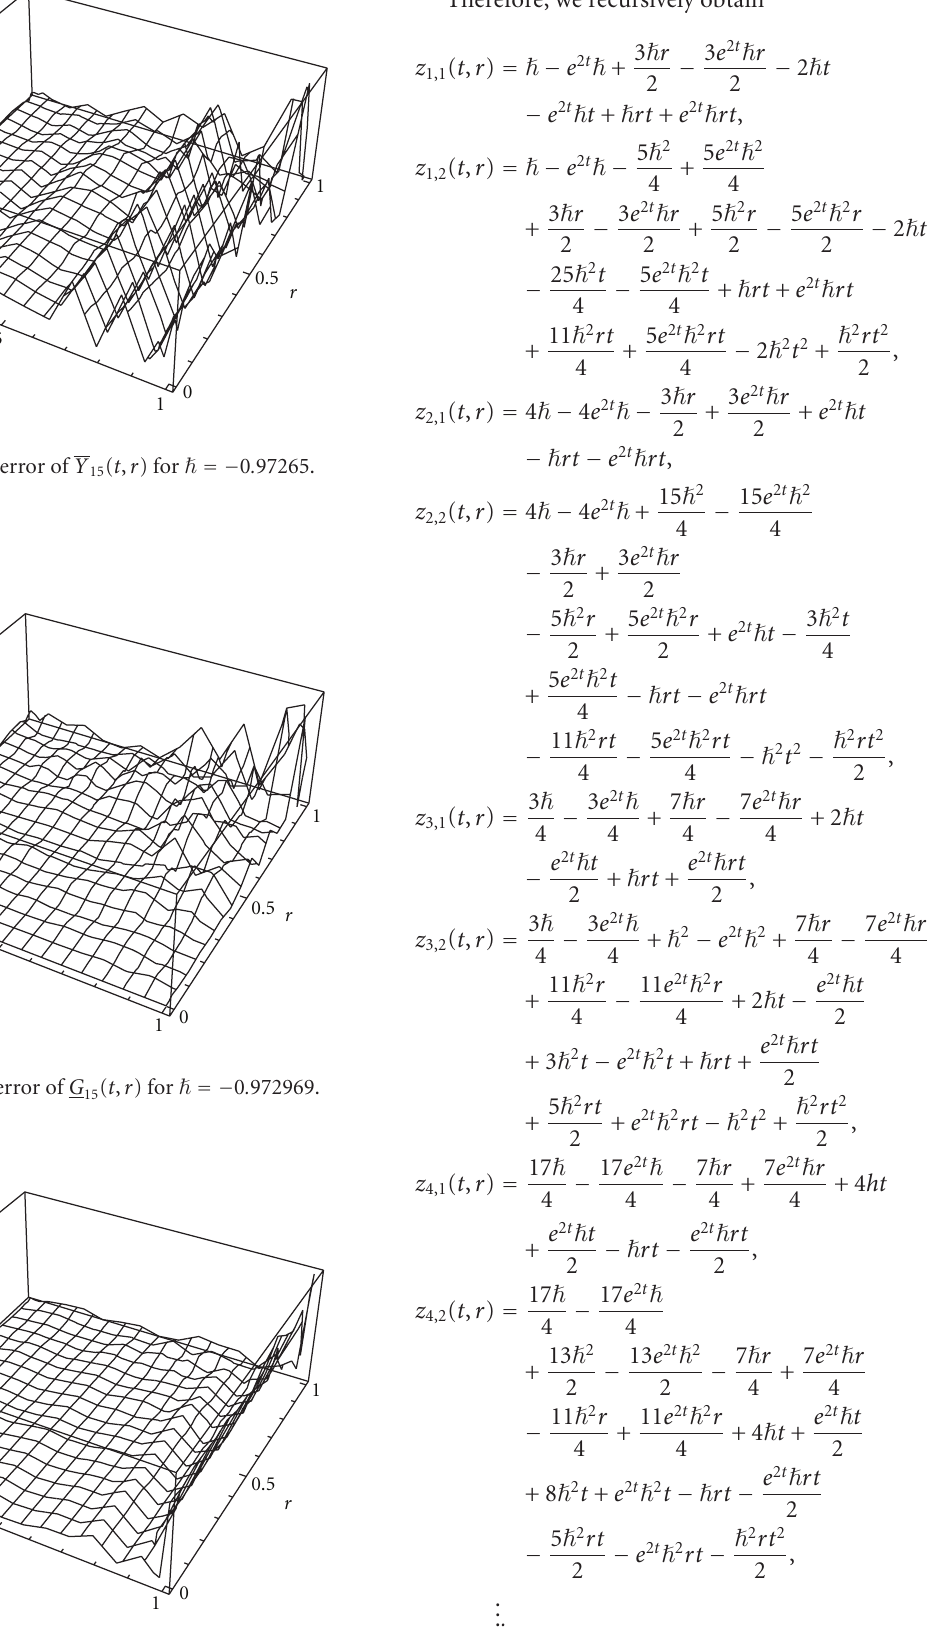
Figure 18: Absolute error of G 15 ( t , r ) for (cid:2) = − 0 .